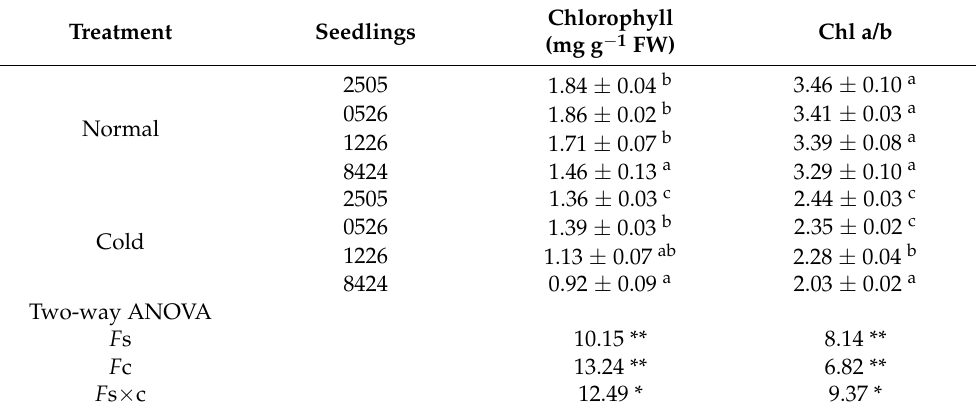
Table 3. Variability of total chlorophyll content and ratio of Chl a/b between different graft combina- tions after cold